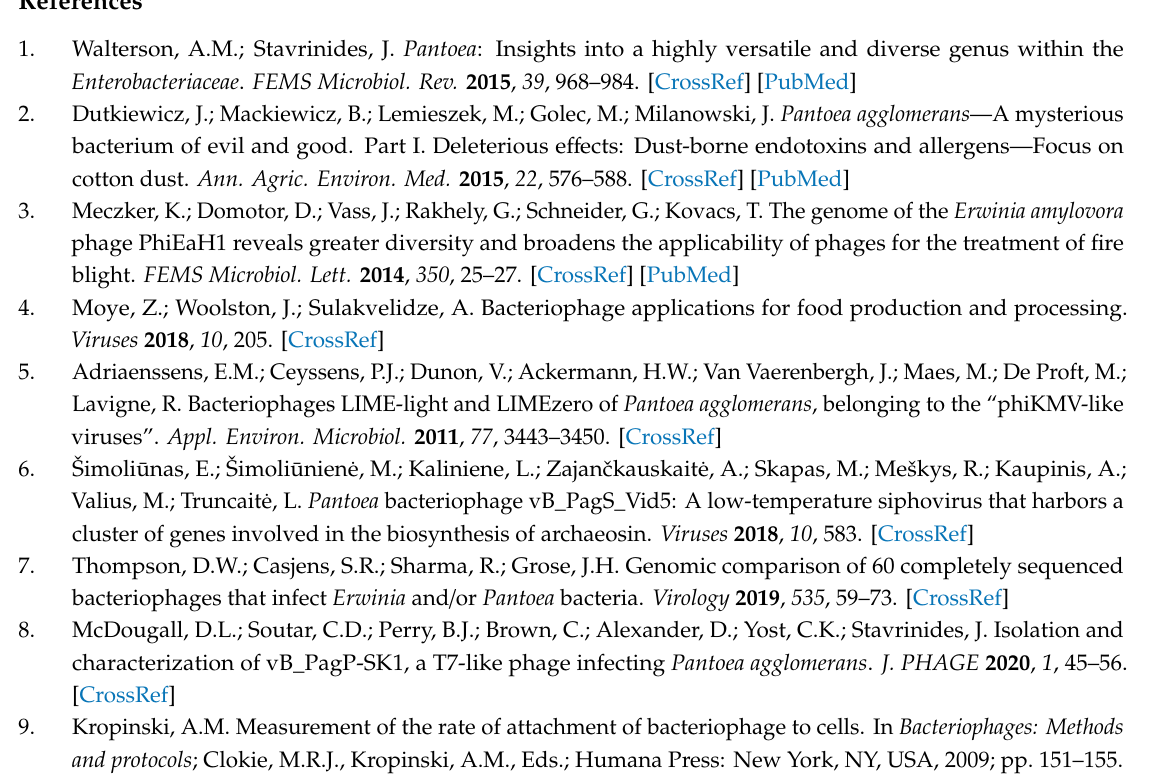
Table S1: A list of Pantoea bacteriophages with completely sequenced genomes, which have been published and / or deposited in the public databases. Table S2: Bacterial strains used in this study to determine the host range of phage AAS21; Table S3: AAS21 ORFs with homologues in other viruses or cellular organisms. Table S4: AAS21 virion proteins identified by MS. Table S5: AAS21 tRNAs identified with tRNAscan-SE and ARAGORN. Table S6: Top matches for BLAST-based alignments of whole genome sequences of AAS21 and its closest relatives generated using PASC. Figure S1: The e ff ect of temperature on the e ffi ciency of plating of phage AAS21 on the culture of P. agglomerans strain AUR. Figure S2: Adsorption assay of phage AAS21. Figure S3: Progressive Mauve whole-genome alignment generated using Geneious Prime